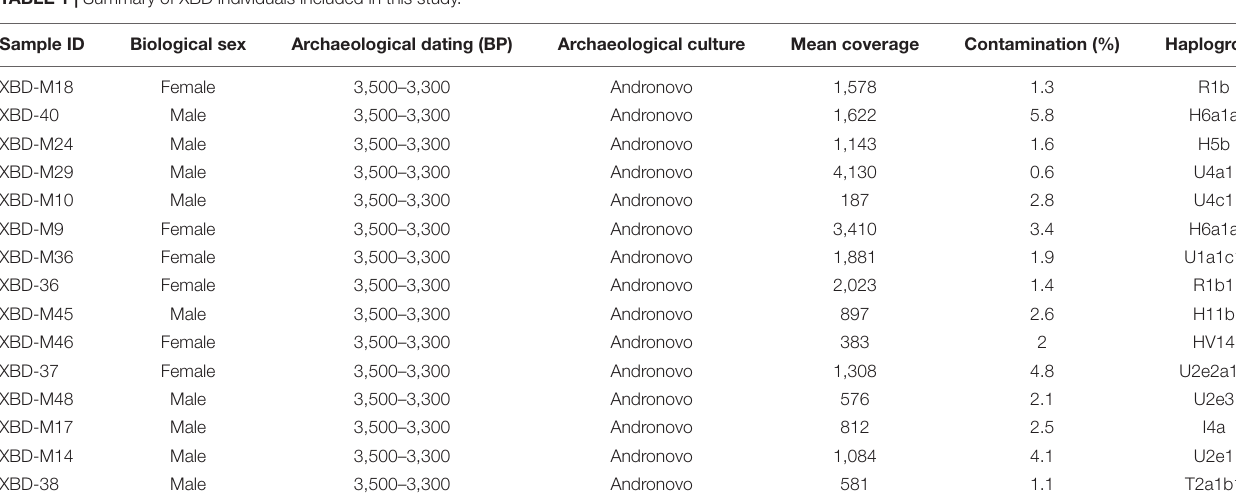
TABLE 1 | Summary of XBD individuals included in this